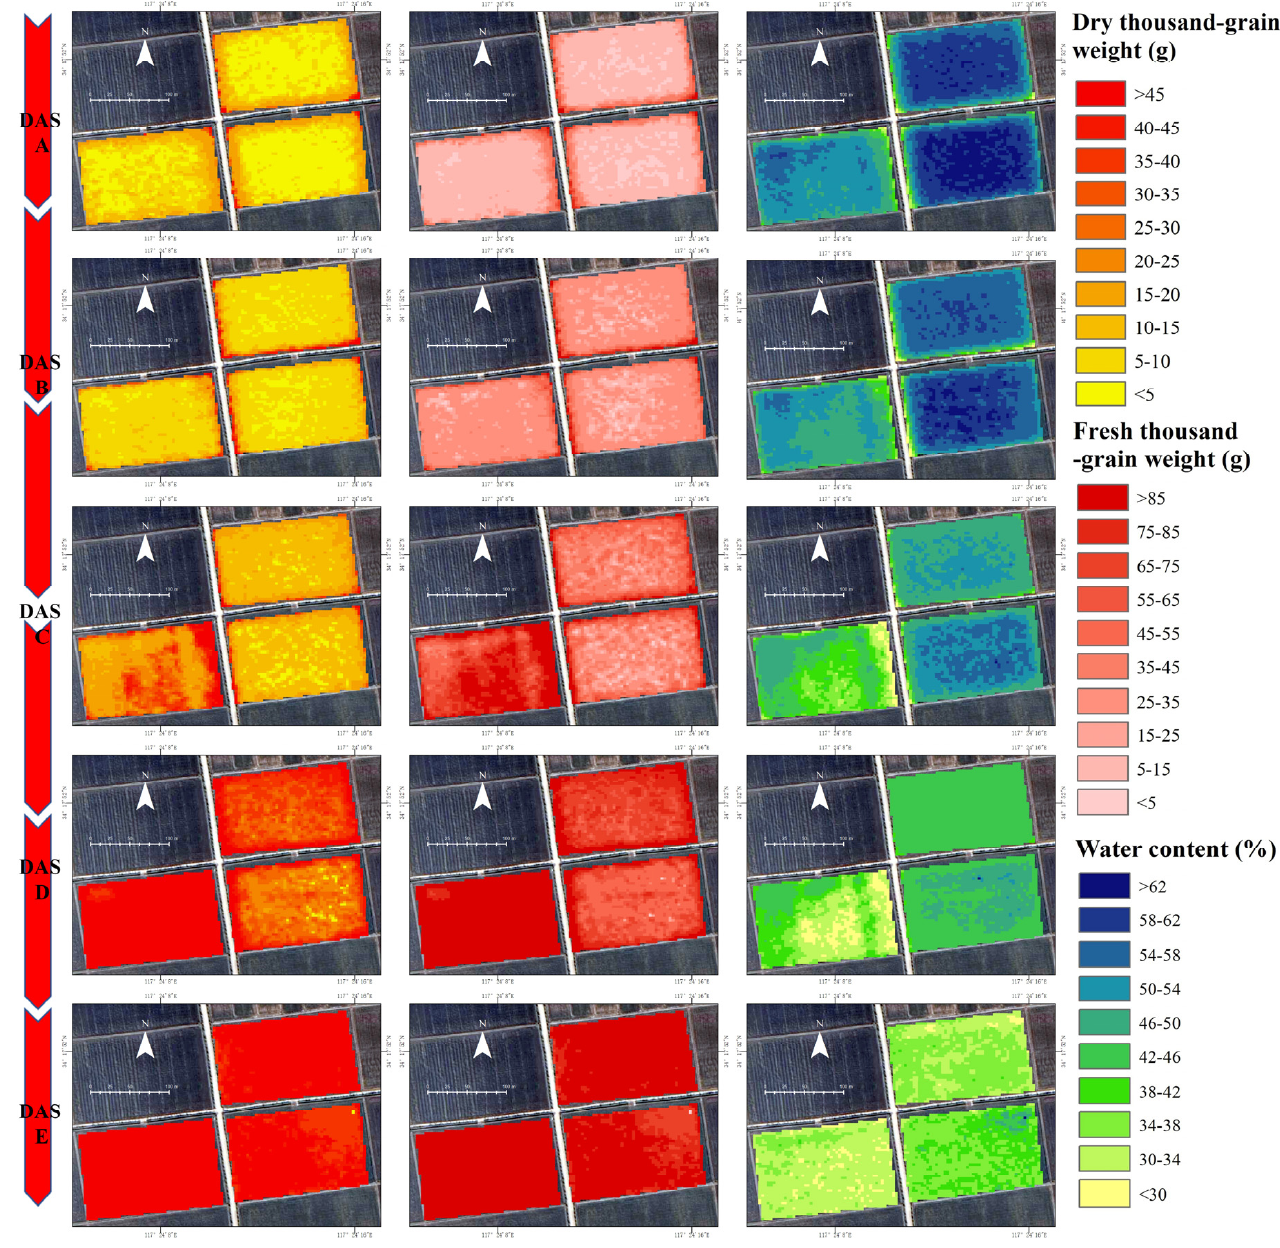
Figure 8. Spatial and temporal variability maps for three indicators of wheat grain-filling process using VIs for three